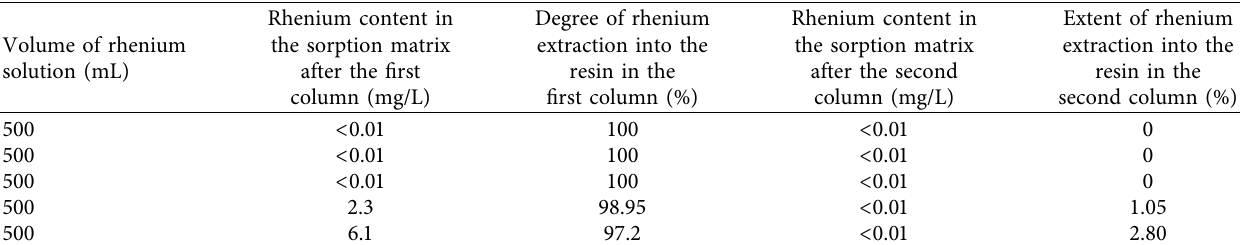
Figure 6: Cake before (a) and after (b) leaching. Table 3: Results of rhenium